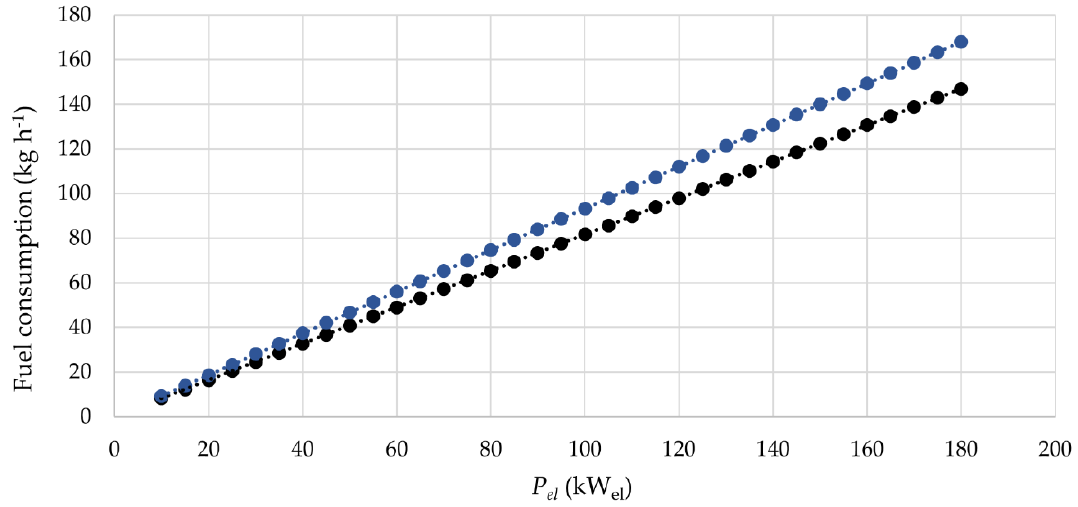
Figure 2. Dependence of material consumption on the electric output of a wood chip unit with a moisture content of 20% (black) and 30% (blue) by weight.